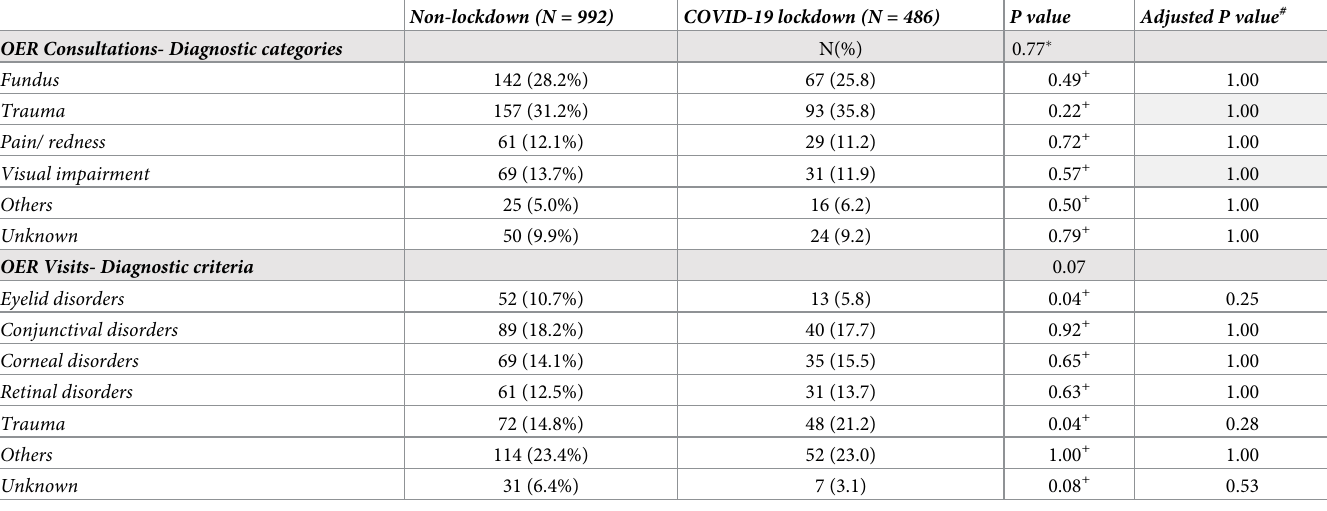
Table 2. Distribution of diagnostic categories between OER visits and consultations in the non-lockdown and COVID-19 lockdown